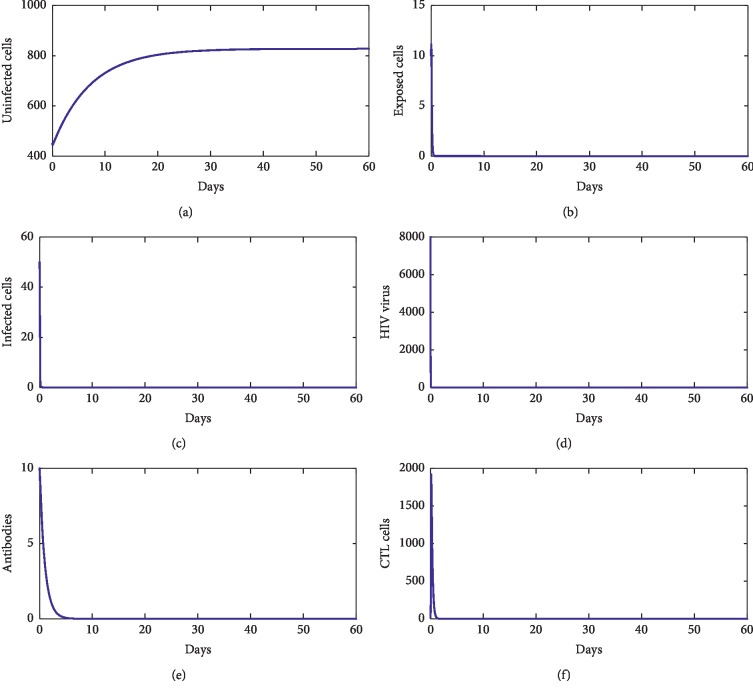
The behavior of the disease for λ=10, d1=0.0139, k1=0.04, d2=0.0495, k2=1.1, d3=0.5776, a=2, d4=0.6, q=0.05, g=10−11, h=0.1, p=0.0024, c=0.15, and b=0.5.